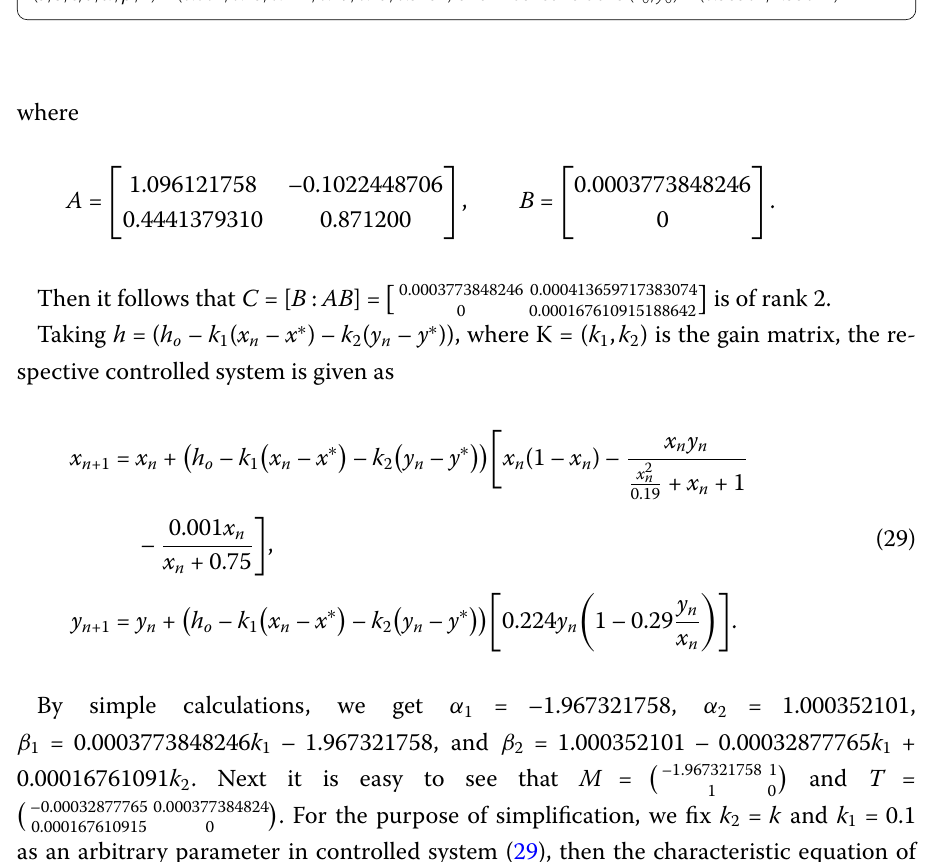
Figure 5 MLE and bifurcation diagrams for model (2) in the interval 0.4 ≤ h ≤ 0.99 with parameters ( a , b , c , d , α , β , h ) = (0.001,0.75,0.224,0.29,0.19,0.5731) and initial conditions ( x 0 , y 0 ) =